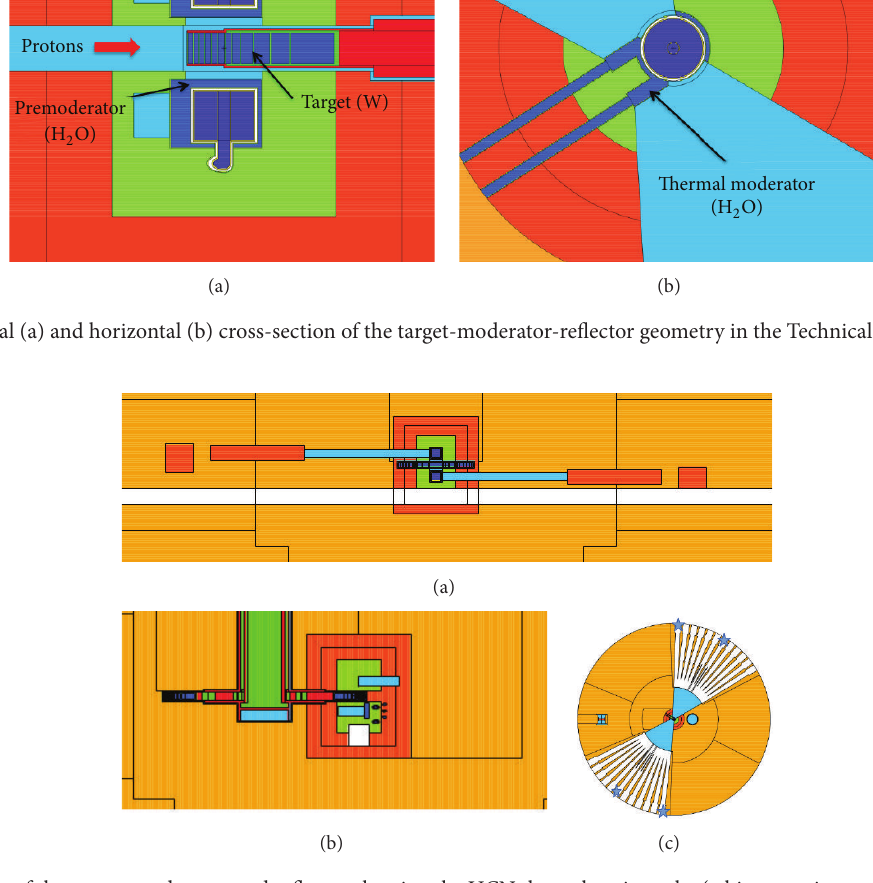
Figure 2: Geometry of the target, moderator, and reflector showing the UCN through-going tube (white areas in upper and lower left-hand inserts) placed at 𝑦 = −47.5 cm (central), corresponding to the topmost of the studied geometries. The blue stars in the lower right-hand insert show the position of the lower point detectors. Note that the 𝑥𝑧 -plane (lower right-hand insert) is cut at 𝑦 = −18 cm; wherefore the UCN tube is not